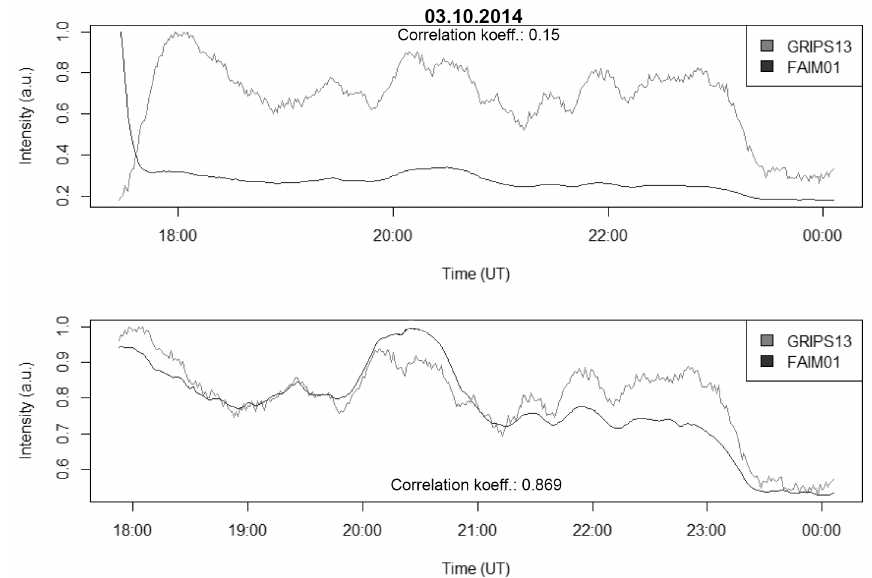
Figure 6. Intensity time series for the night of 3 to 4 October 2014. The black line shows the mean value over all pixels of FAIM1 within the FOV of GRIPS13 and the grey line shows the intensity measured with GRIPS13 integrated between 1500 and 1600nm. Both data sets are averaged to 1min mean values to avoid effects of different sampling rates and normalised to their individual maximums. Top: the entire time interval from the start of the measurement until 00:00UTC when clouds emerged. A correlation of only 0.15 is determined. Bottom: same as above, but the first 25min of twilight are avoided. The correlation now increases to 0.87.